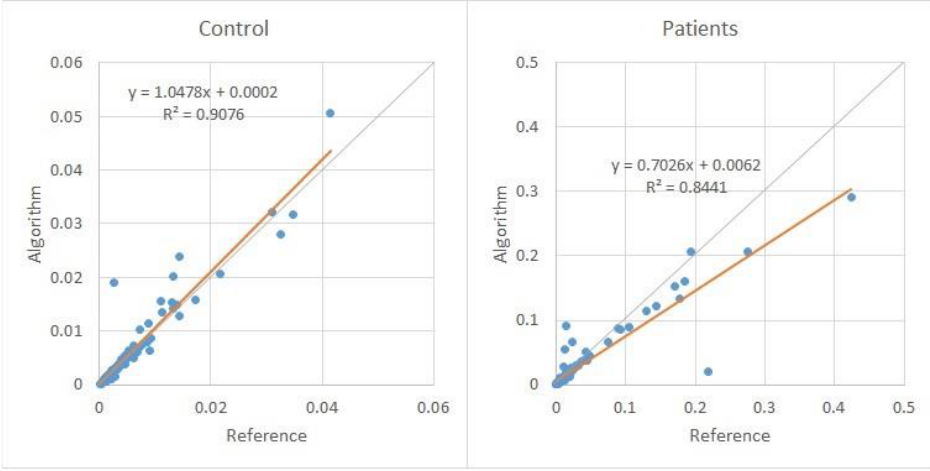
Figure 6. Comparison of the NHR values for the 90 control measurements (left-hand side) and 90 patient measurements (right-hand side).